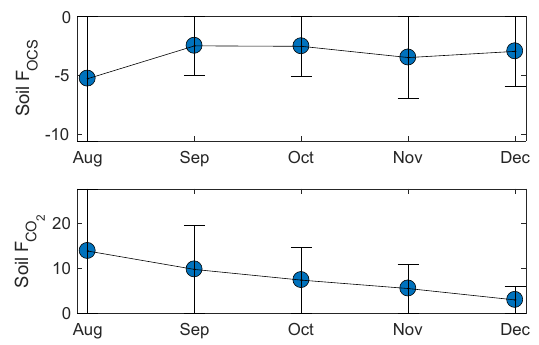
Figure 5. Surface F OCS and F CO from sites 2 and 3. Site 1 was atypical (see Sect. 2.7), and therefore fluxes are not shown. Values for site 1 F OCS and F CO 0 . 3pmolm − 2 s − 1 and − 83 ± 2µmolm − 2 s − 1 , respectively. Error bars indicate standard